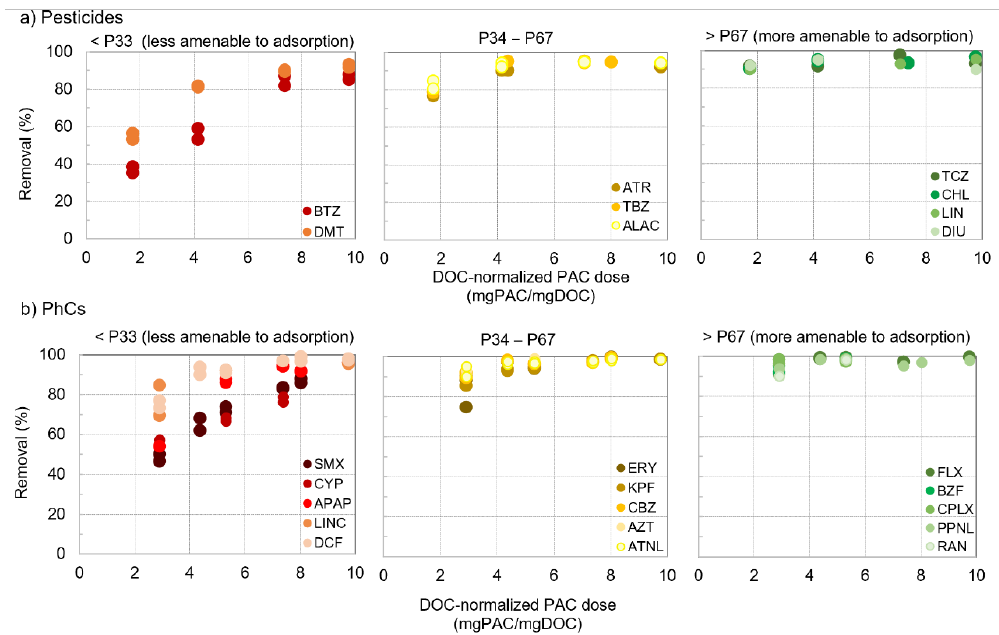
Figure 5. Removal as a function of DOC-normalized PAC dose for a pool of individual pesticides ( a ) and PhCs ( b ) presenting different amenabilities to PAC adsorption.